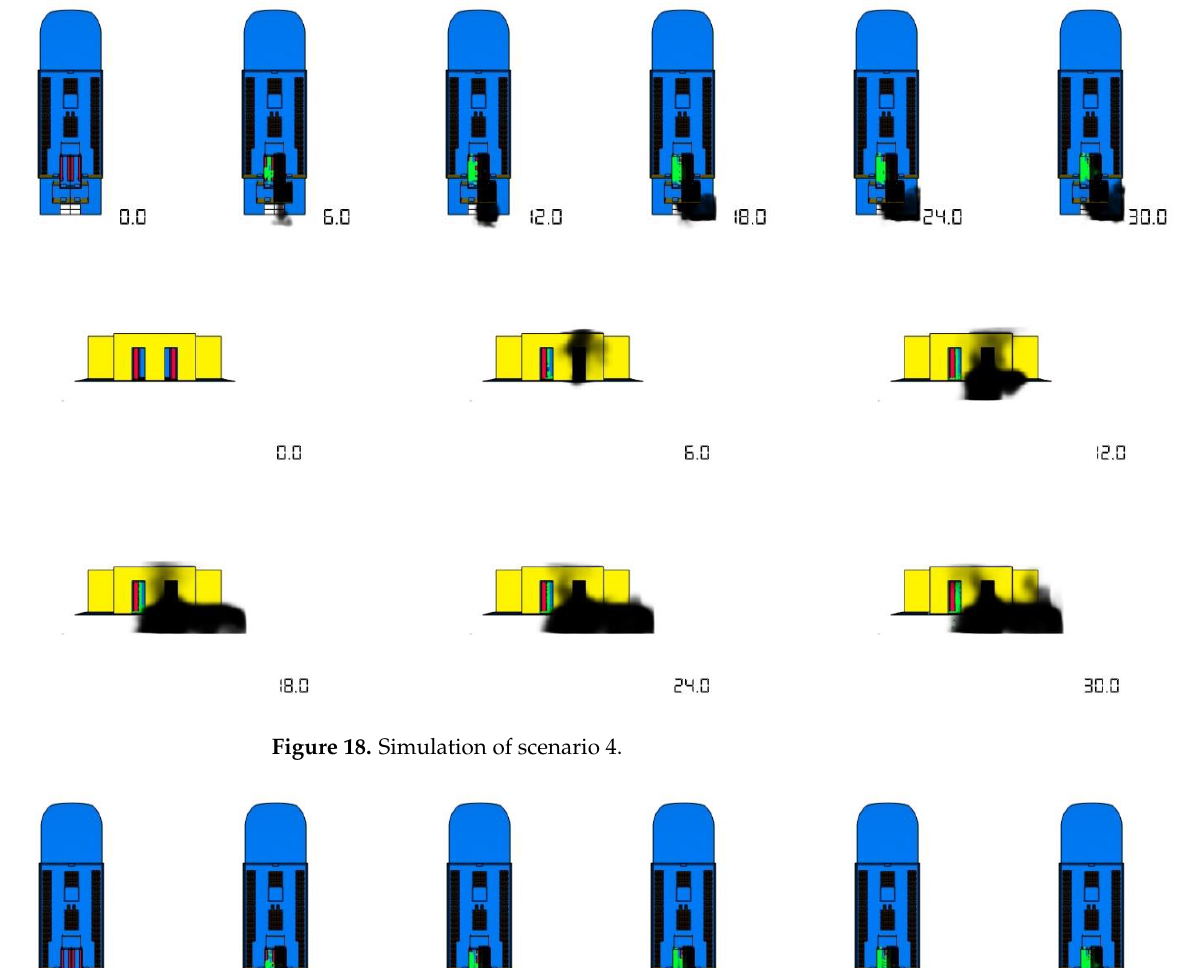
Figure 17. Simulation of scenario 3.